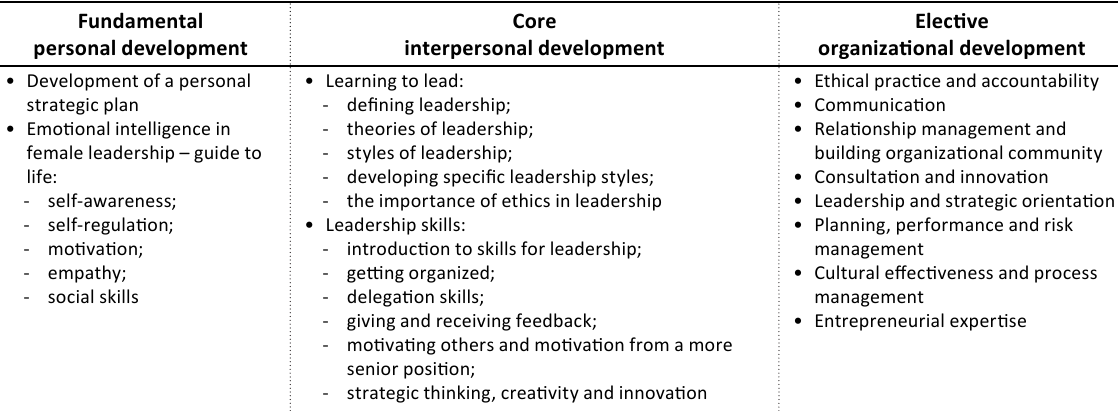
Table 12. Example of key development areas and related topics per